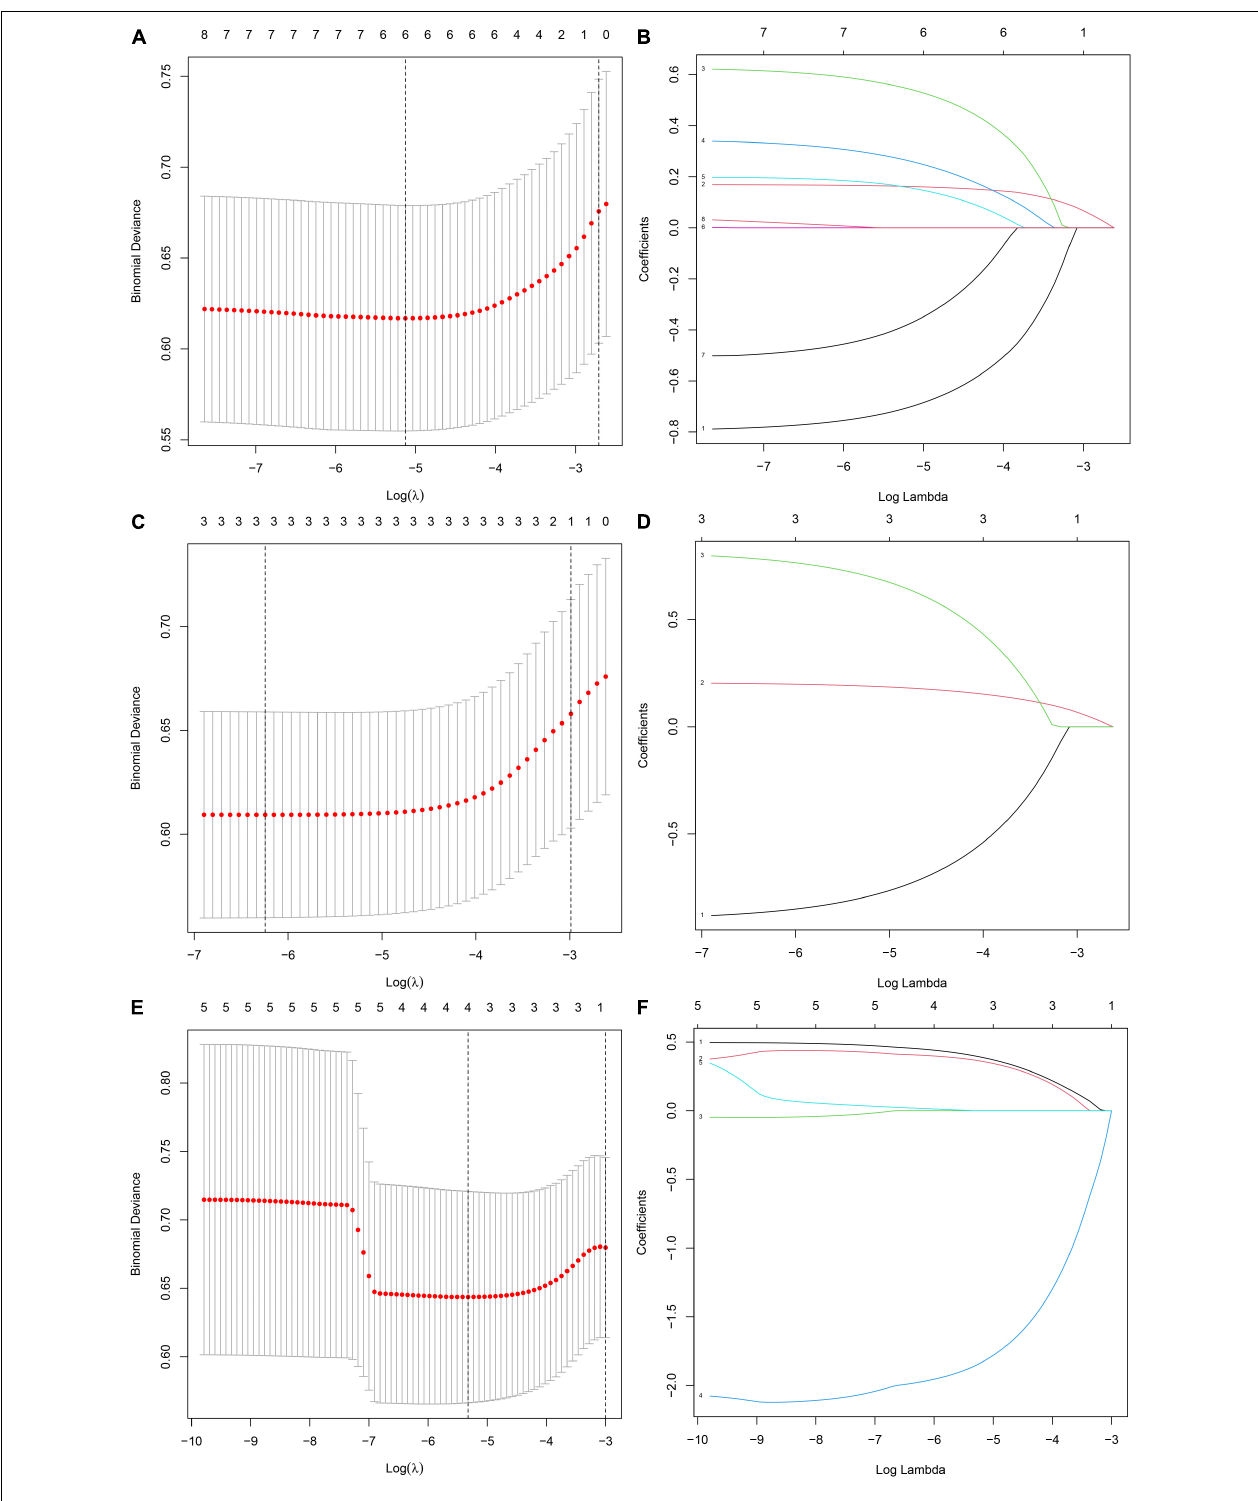
FIGURE 4 | Different types of influencing factors (6 mixed factors, three baseline factors, four blood factors) selection process using lasso regression for nomogram, respectively. (A,B) Six mixed factors. (C,D) Three baseline factors. (E,F) Four blood factors. (A,C,E) The optimal parameters (lambda) in 3 LASSO models are selected with 10-fold cross-validation via minimum criteria, respectively (59). Draw vertical dashed lines at the optimal value using the minimum criteria and the 1 SE of the minimum criteria (47). (B,D,F) Distribution diagrams of LASSO coefficients for three types of factors generated by log (lambda) sequence, respectively (47). Vertical lines are drawn at the best lambda to select 6, 3, and 4 factors with non-zero coefficients, respectively.